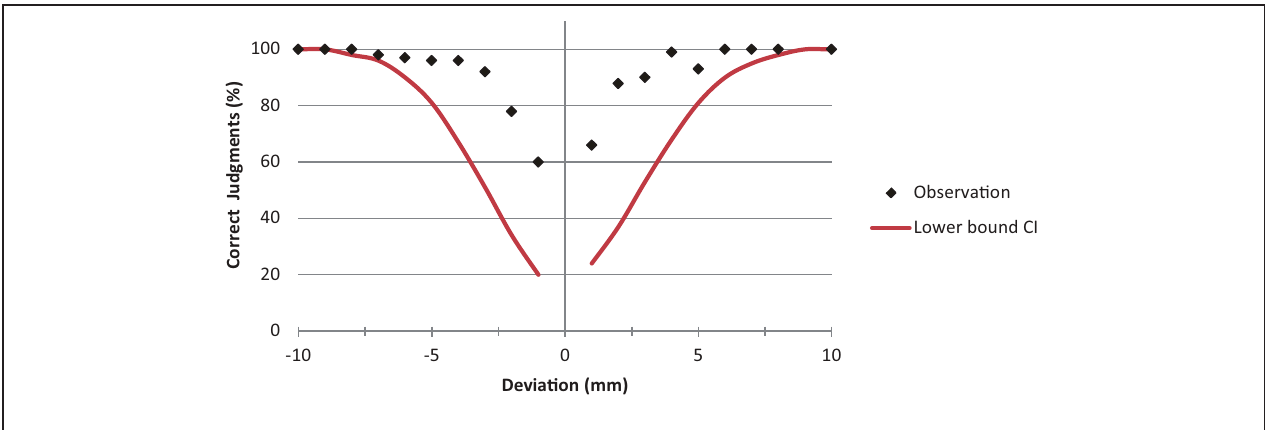
FIGURE 2 | Dependency of correct judgment on deviation error. The percentage of correct judgments is plotted as a function of bisection error. The graph shows the normative data of 71 healthy subjects (black dots)